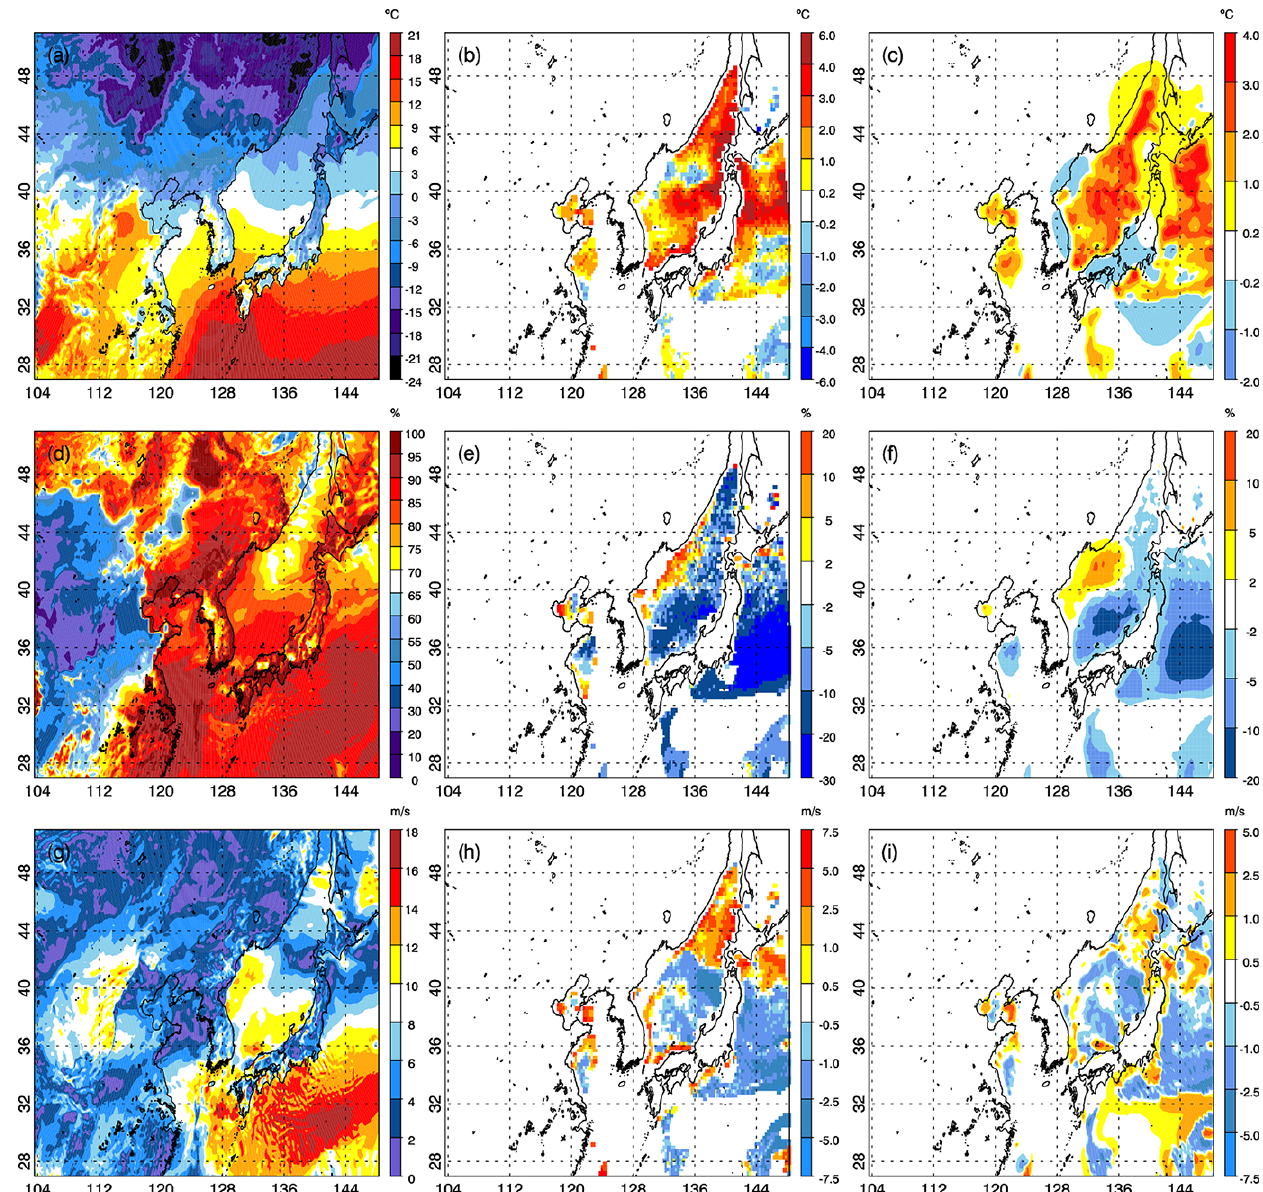
Figure 6. WRF model background for (a) 2m temperature ( ◦ C), (d) 2m relative humidity (%), and (g) 10m horizontal wind speed (ms − 1 ), difference between observation and model background for (b) 2m temperature, (e) 2m relative humidity, and (h) 10m horizontal wind speed, and difference between data assimilation analysis and the background for (c) 2m temperature, (f) 2m relative humidity, and (i) 10m horizontal wind speed at 09:00UTC 7 March